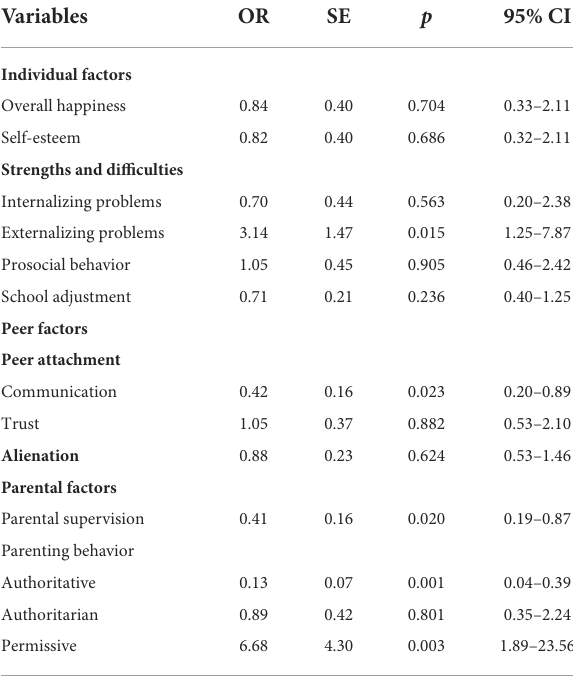
TABLE 3 Factors influencing problematic smartphone use in preteens ( N =